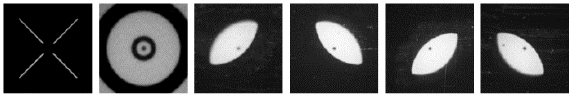
Figure 1. Most frequent shapes of FM in AAP